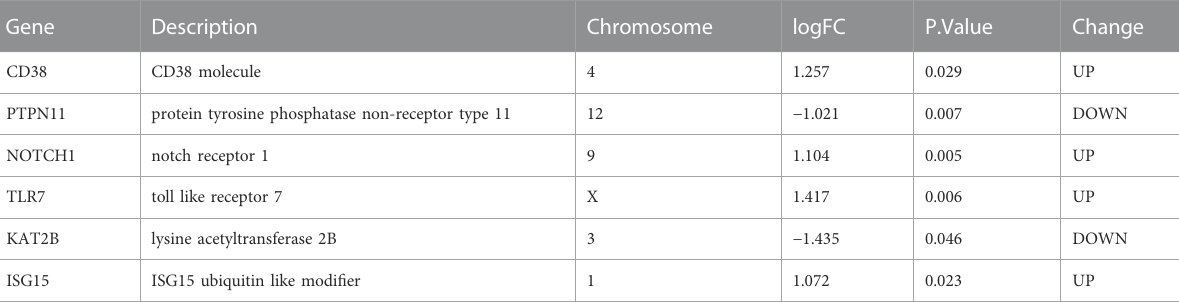
TABLE 2 Detail information about the six hub genes identi fi ed by machine learning.